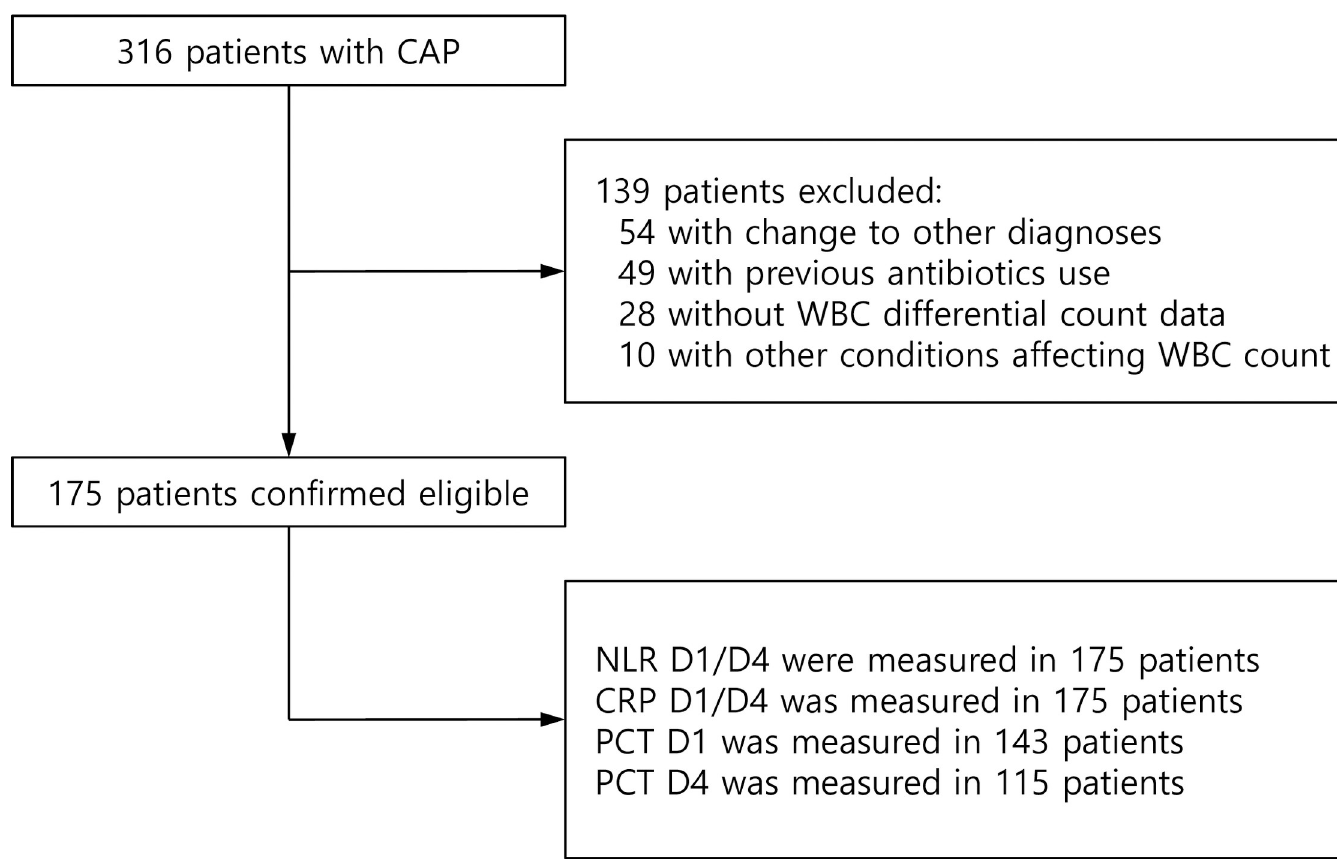
Fig 1. Study flow